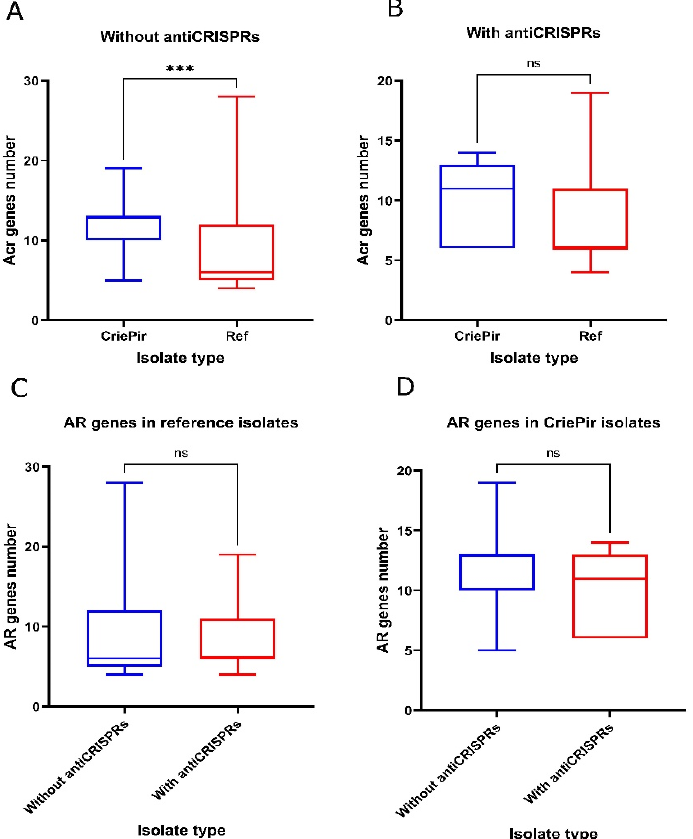
Figure 5. Comparison of the number of AR genes in CriePir and reference (Ref) P. aeruginosa isolates